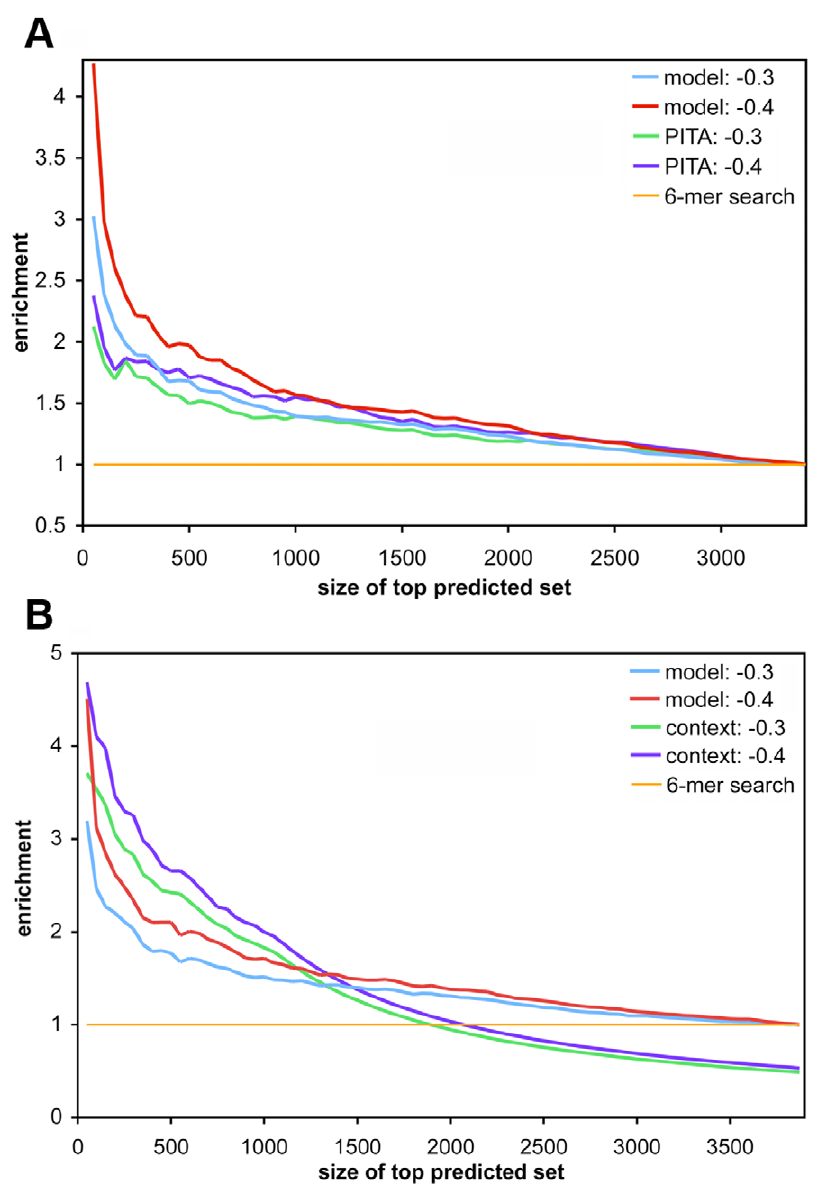
Figure 5. Comparison of the prediction model to other existing tools. (A) Our model score vs PITA score. Model-predicted scores and enrichment values were computed as in Figure 4C. We used PITA scores with flanking length of 3 and 15 bases upstream and downstream, for which the original study reported better performance compared to no flanking region [9]. (B) Our model score vs TargetScan’s context score. Models from the 6-mer training set were used (cf. Figure 4C). TargetScan UTRs without the required canonical sites (i.e. no context score) were ranked at the bottom of the predicted list.